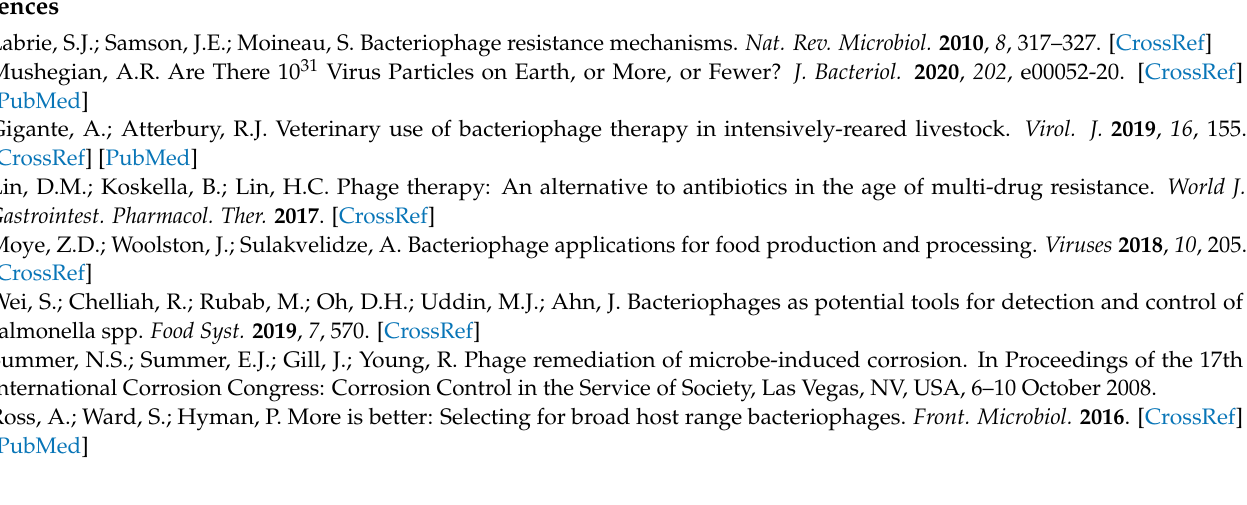
this study. Table S3: Host range determination of Listeria phages isolated using different enrichment methods. Table S4: Host range determination of Salmonella phages isolated using different enrichment methods. Table S5: Host range determination of Pseudomonas spp. Environmental phages isolated using different enrichment methods. Table S6: Host range determination of Pseudomonas spp. Clinical phages isolated using different enrichment